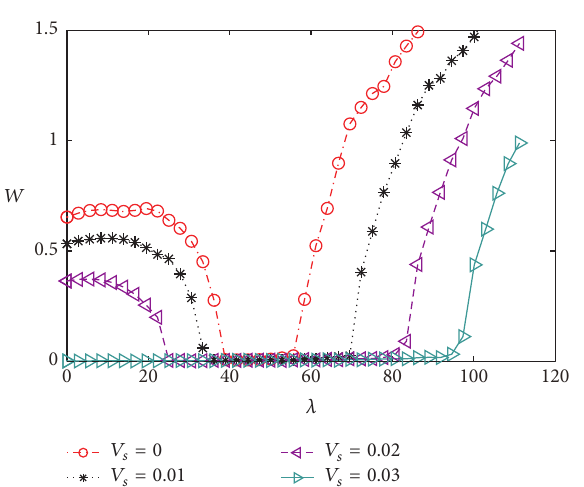
Figure 19: Influence of 𝑇 on buckling, flat, and flutter